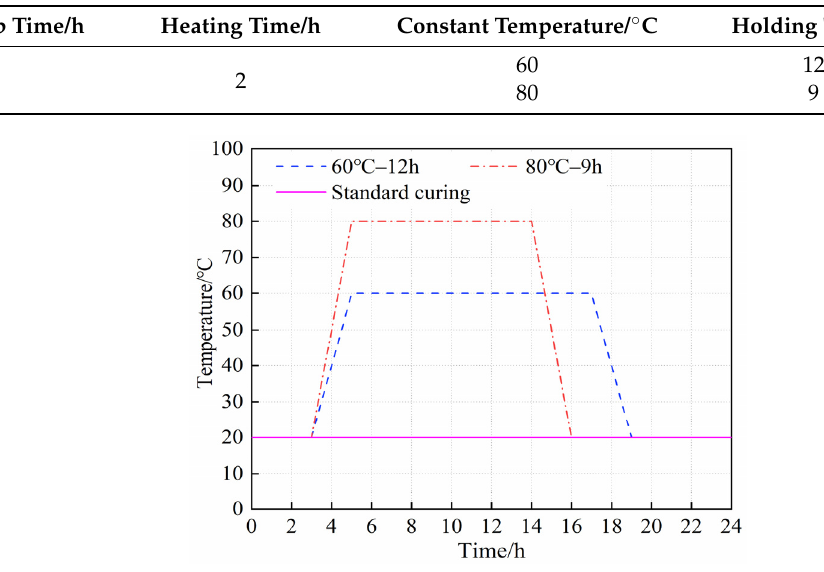
Table 3. Control parameters of the steam curing system.